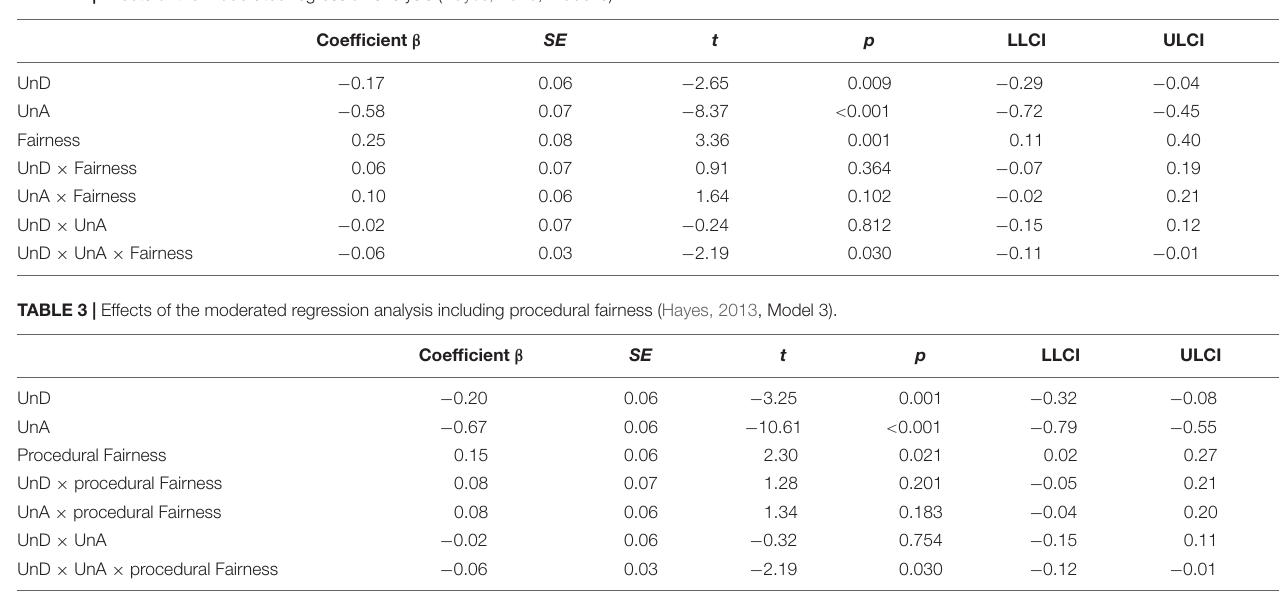
FIGURE 1 | The effects of uncertainty about the advisor (UnA), uncertainty regarding the investment decision (UnD), and fairness on people’s intention to cooperate with the advisor. Plotted values reflect intention to cooperate at one standard deviation below and above the standardized values for fairness. Significant slopes are marked with asterisks. Higher values reflect higher intention to cooperate. TABLE 2 | Effects of the moderated regression analysis (Hayes, 2013, Model 3).